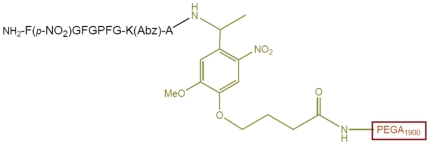
Representation of the peptide bound to PEGA1900 resin using the PLL linker (drawn in green).